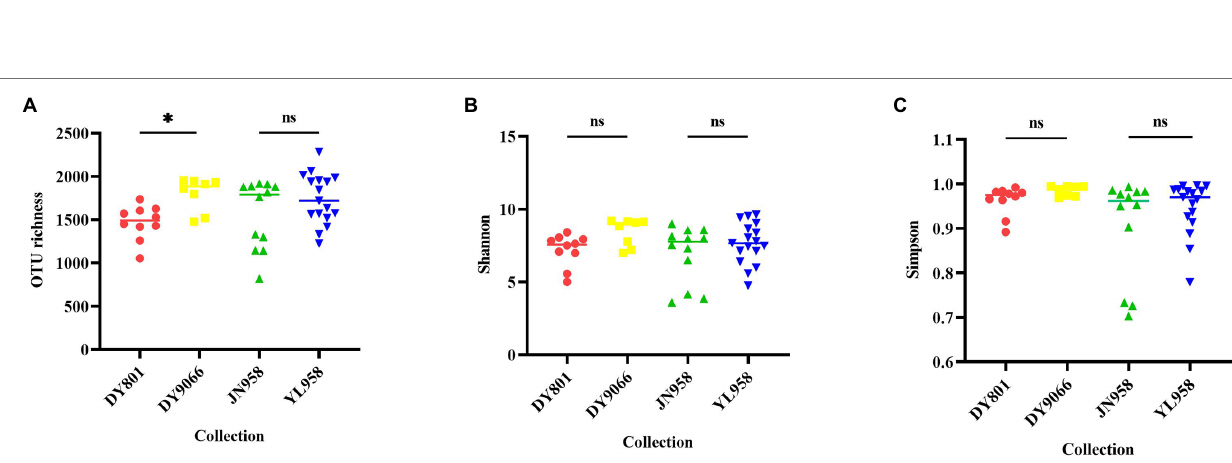
FIGURE 6 | Principal coordinates analyses (PCoA) of the intestinal bacterial microbiota based on weighted Unifrac distances at the OTU level. (A) Analysis of two populations on two maize varieties at a same collection site. (B) Analysis of two populations on a single maize variety planted at two collection sites. Each point in the Figure represented an individual insect sample, and samples in the same population were indicated by the same color.